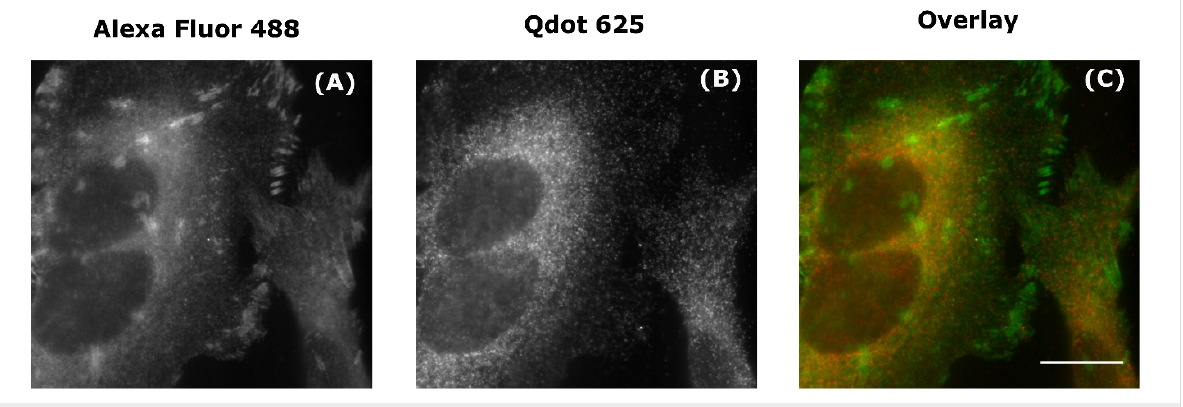
Figure 4: Non-specific labelling of talin with Qdots. Fixed HeLa cells were dual labelled with green Alexa Fluor 488 (A) and red Qdot 625 (B) to produce an overlaid wide-field image (C). Scale bar is 20 μ m.